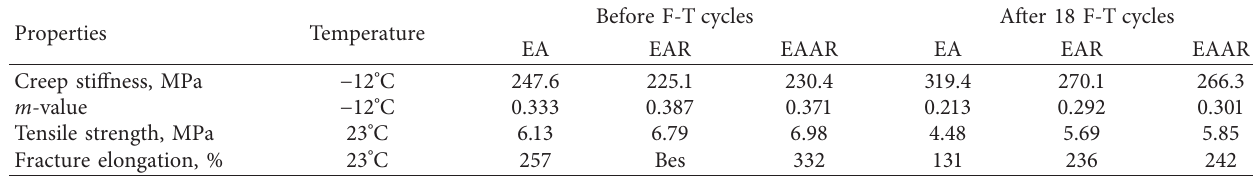
Table 5: Properties of EA, EAR, and EAAR before and after long-term F-T cycles [61]. Before F-T Properties Temperature